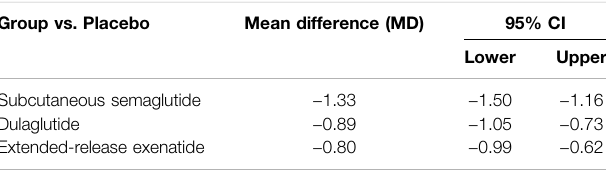
TABLE 1 | Change in the HbA1c level in patients receiving metformin-based background therapy. Group vs. Placebo